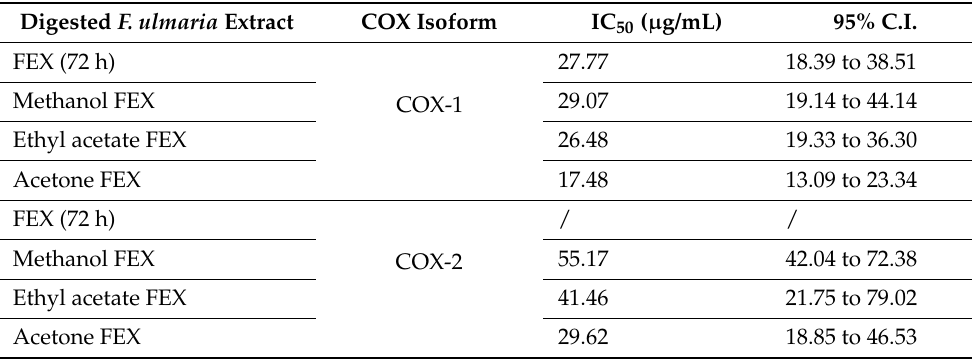
95% C.I.; 95% interval of